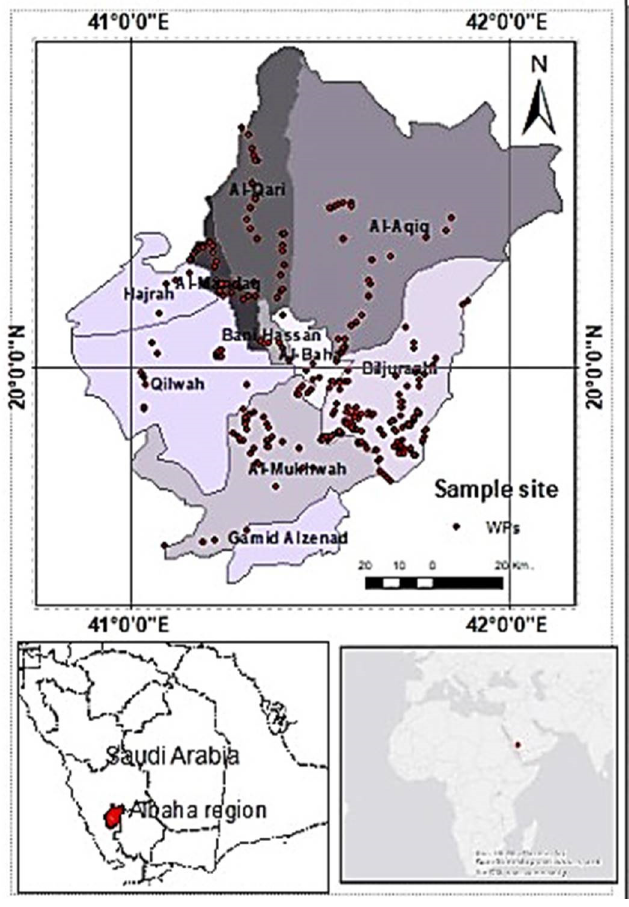
Figure 3. Map of the study area and locations of sample